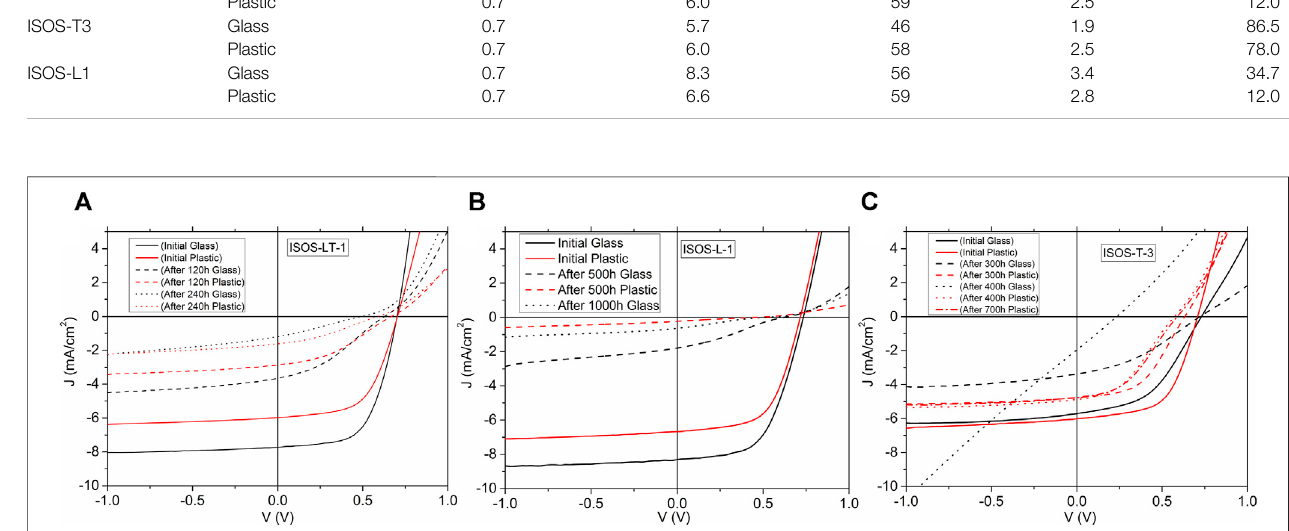
FIGURE 2 | Summary of initial and aged J-V curves for the three degradation studies carried out: (A) in the Q-Sun chamber (ISOS-LT-1), (B) under solar simulator under constant temperature (ISOS-L-1), and (C) in the thermal chamber (ISOS-T-3).